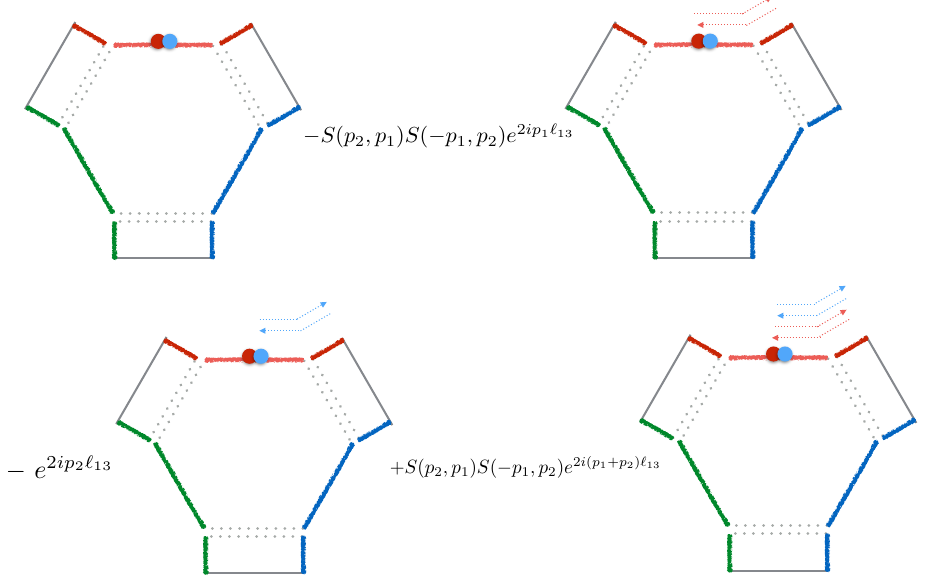
Figure 8 . For the second term, the red colored magnon on the hexagon can get the negative sign p 1 by the propagation e 2 ip 1 ‘ 13 . Then, since the magnon would be scattered with another magnon (cid:0) with p 2 at two times, the S-matrix factors S ( p 2 ; p 1 ) S ( and fourth terms are interpreted as the magnons with ( p 1 ; on the hexagon respectively by added appropriate propagation and S-matrix